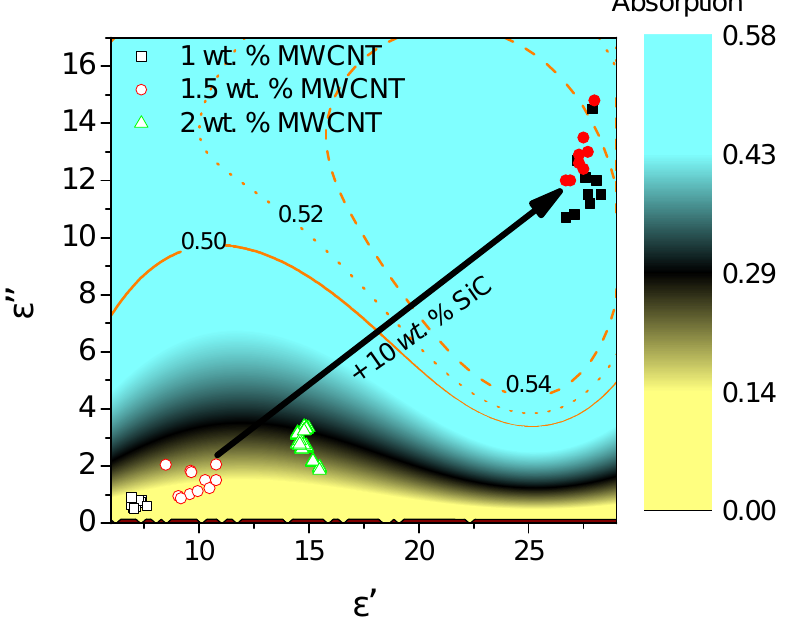
Figure 5. Electromagnetic irradiation (30 GHz) absorption of the planar 1 mm layer plotted as a function of dielectric permittivity. Dots presents the experimentally measured values of the permittivity for the pure MWCNT (open) and hybrid, SiC + MWCNT